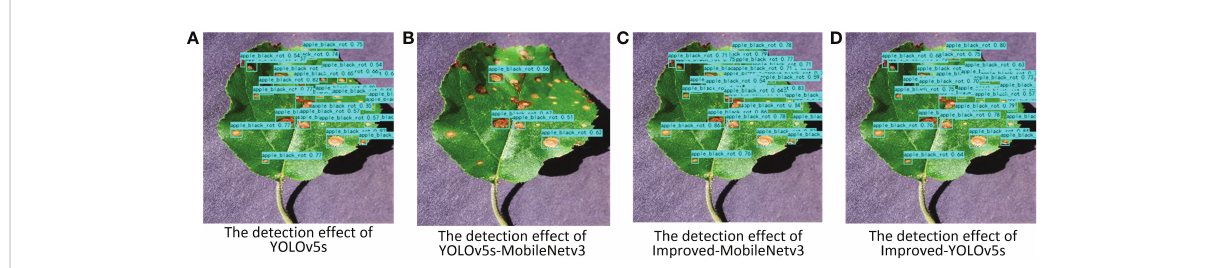
FIGURE 10 Pictures of the detection effect of apple black rot under different backbone networks. (A) YOLOv5s model; (B) YOLOv5s-MobileNetv3 model; (C) Improved-MobileNetv3 model; (D) Improved-YOLOv5s